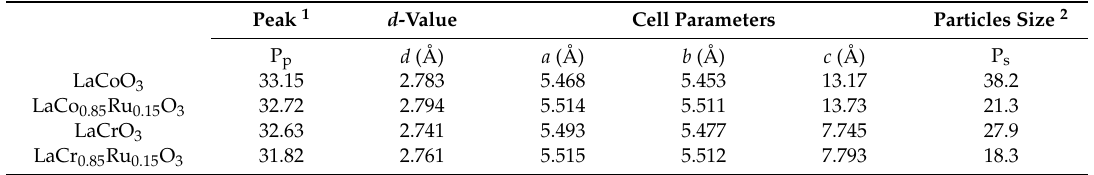
Table 3. The d -values, cell parameters and particles size of LaCr 0.85 Ru 0.15 O 3 and LaCo 0.85 Ru 0.15 O 3 catalysts, including LaCrO 3 and LaCoO 3 as